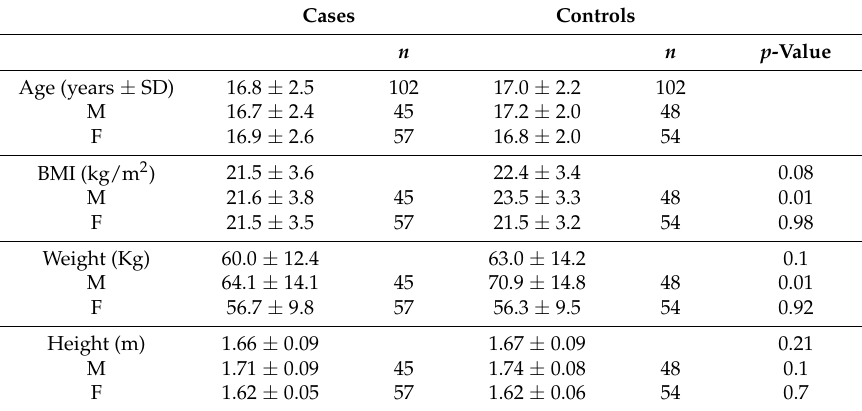
Table 1. Characteristics of the study subjects.